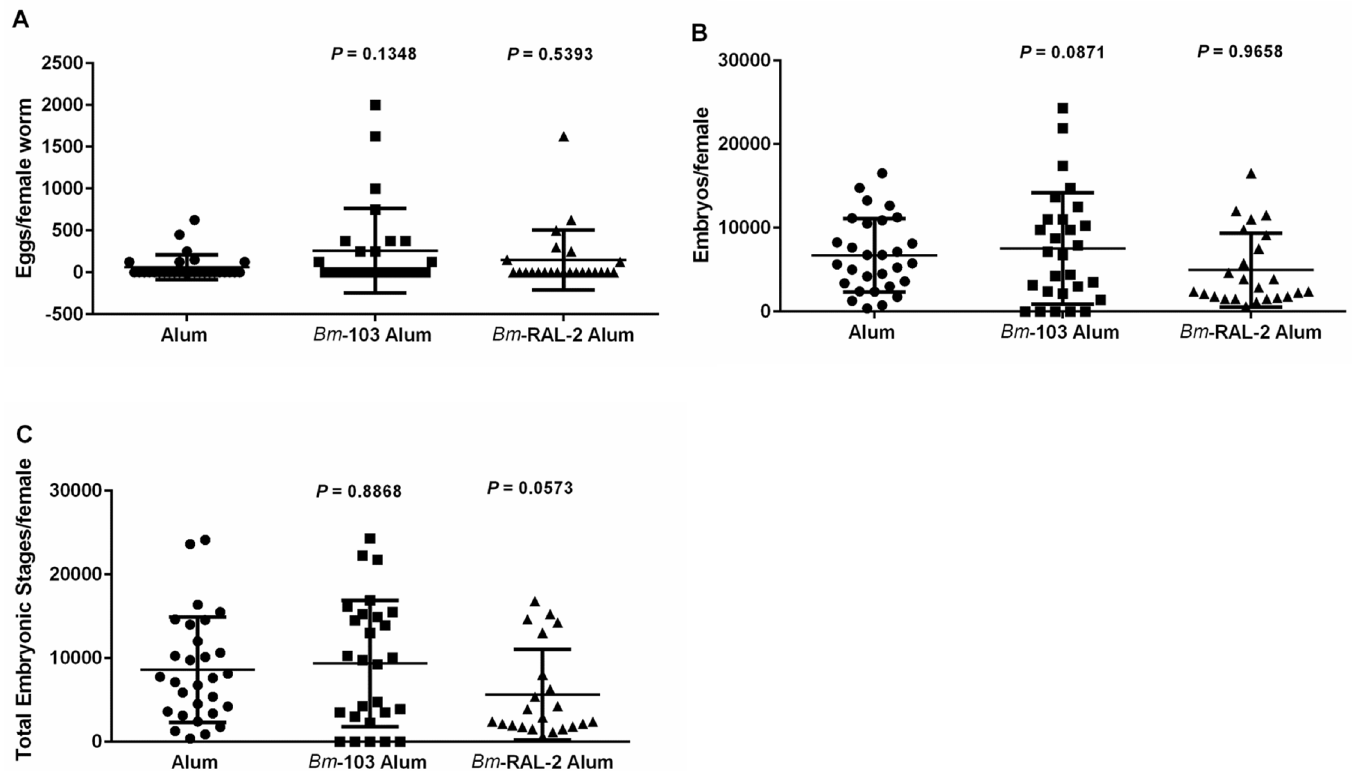
Fig 4. Embryogram data of B . malayi female worms recovered 150 dpi from alum control, Bm -RAL-2 and Bm -103 vaccinated gerbils. (A) Eggs/ female worm; (B) Embryos/female worm; (C) Total embryonic stages/female worm. Statistical significance was determined by Mann – Whitney U Test using GraphPad Prism version 6, P (cid:1) 0.05. The line represents mean with standard deviation.